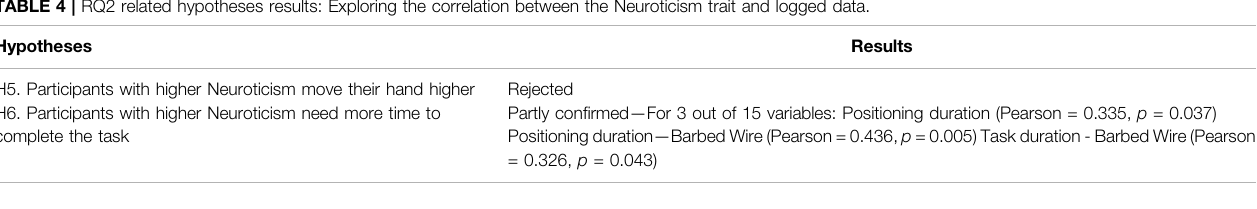
TABLE 4 | RQ2 related hypotheses results: Exploring the correlation between the Neuroticism trait and logged data.